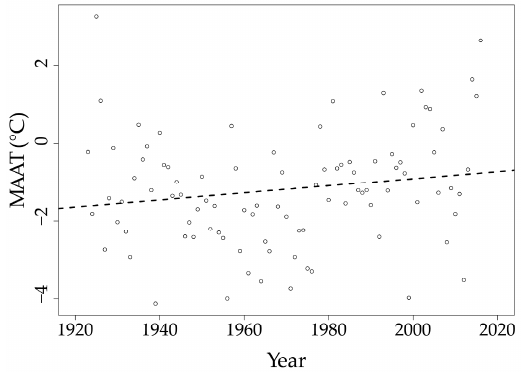
Figure 2. Temperature trend for Bethel, Alaska (200 km east of study area). Linear regression shows a warming trend of Mean Annual Air Temperatures (MAAT): ˆ β 1 = 0.009 ( p = 0.0941), Adjusted R 2 = 0.020.